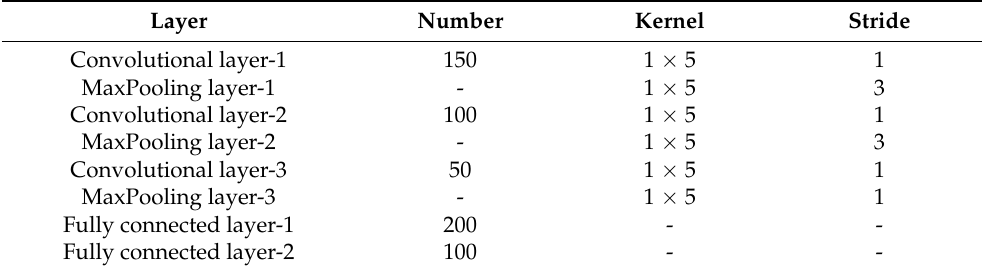
Table 4. Structure of the marine oil spill detection 1D-CNN